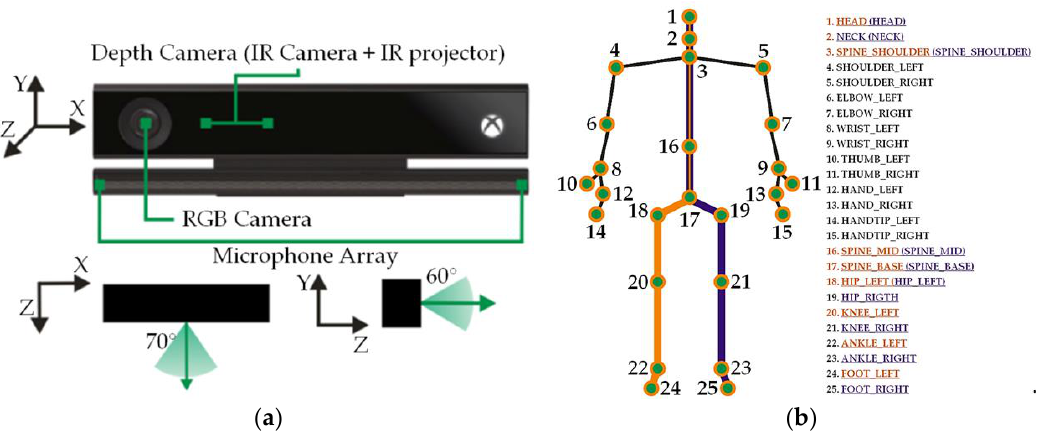
Figure 2. Microsoft Kinect v2: ( a ) Kinect structure and visual field marking; ( b ) the location of 25 parts of the body in Kinect v2.